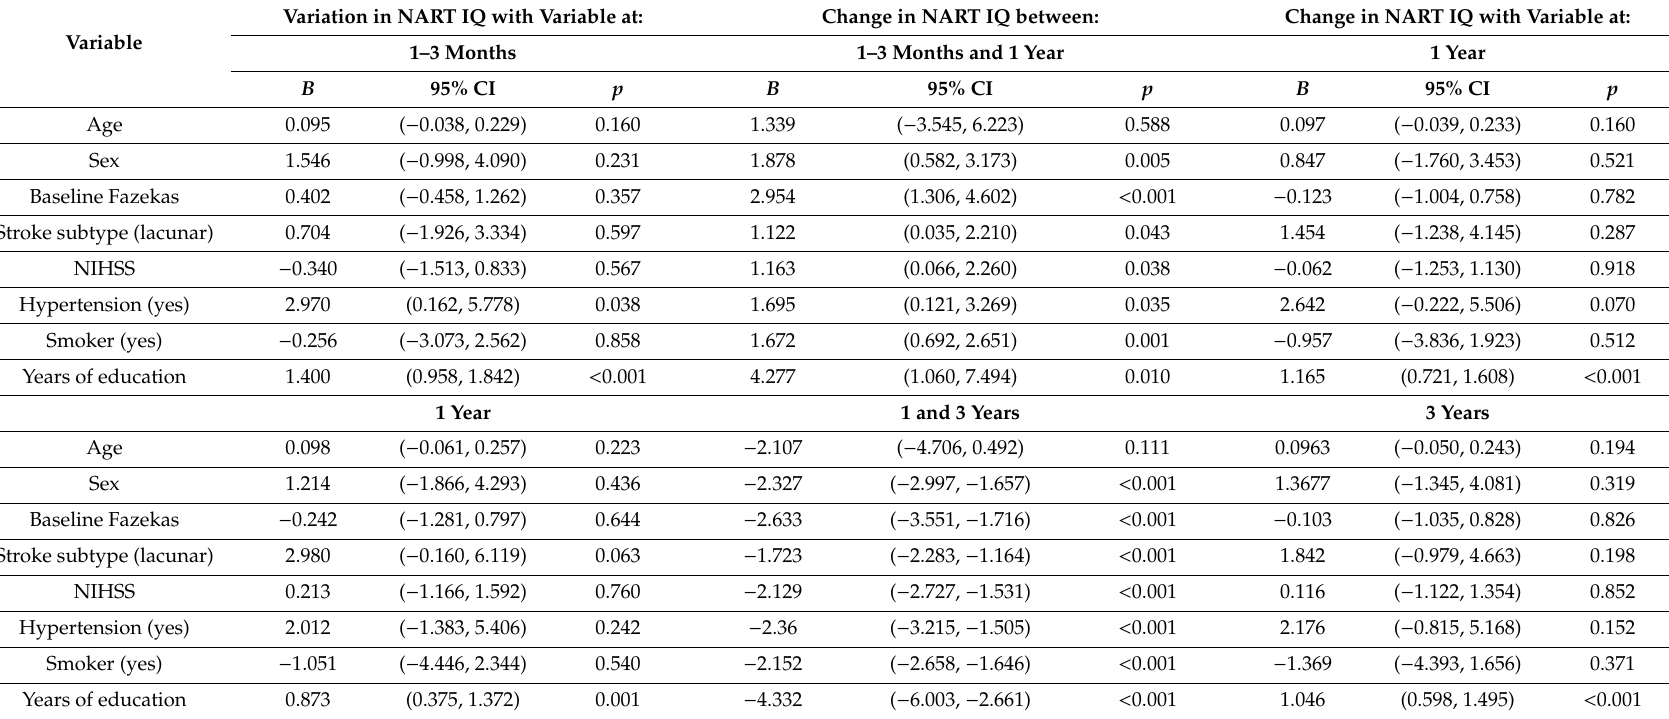
Table 4. Linear mixed e ff ects models showing factors associated with changes in NART IQ at each time-point.